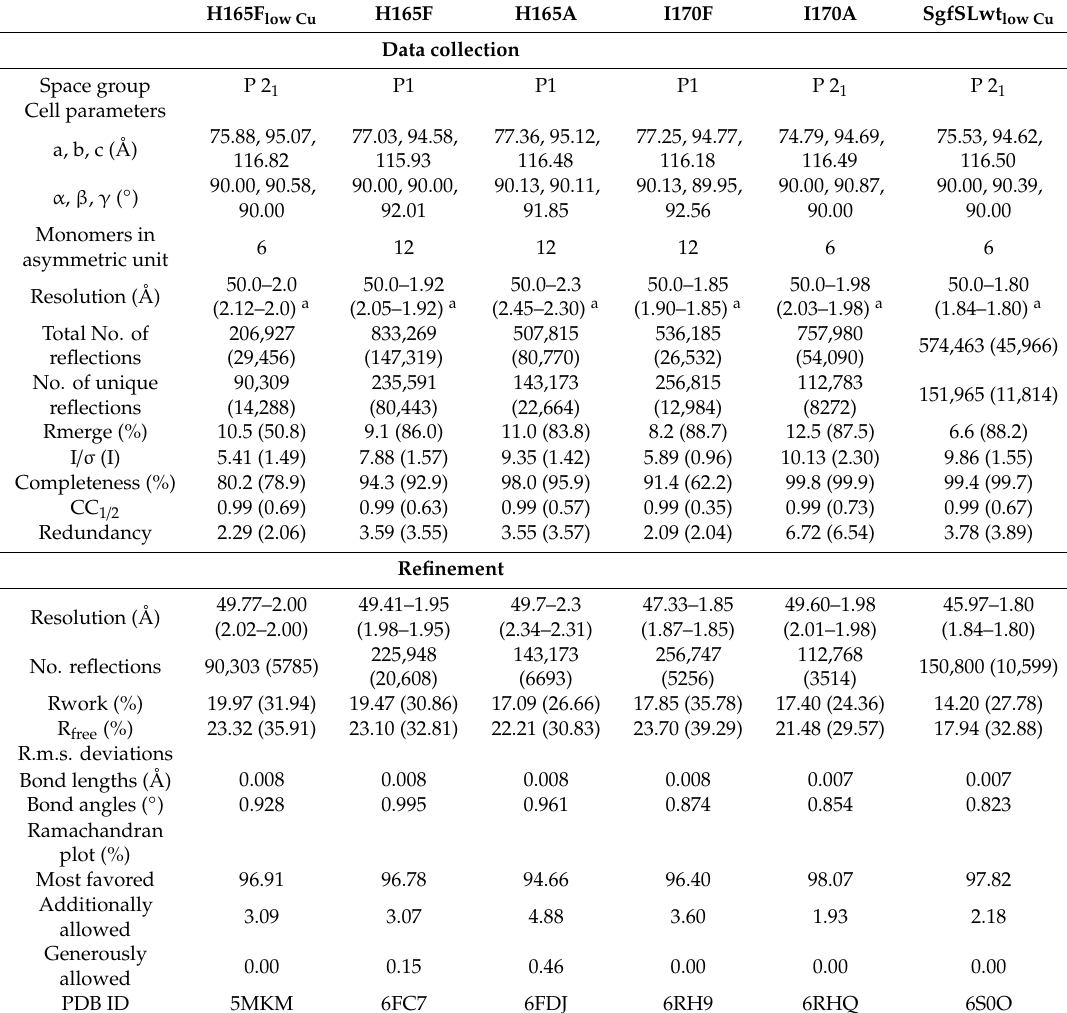
Table 1. Crystallographic Data Collection and Refinement